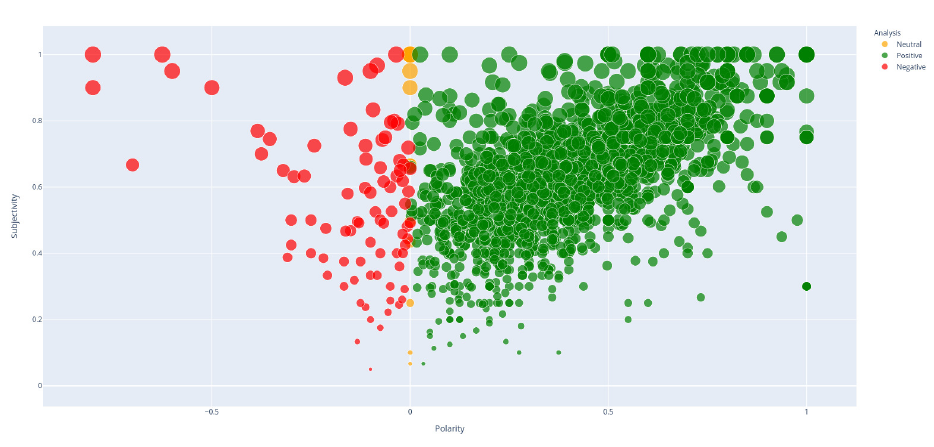
Figure 16. Example of the polarity and subjectivity of the reviews about the Colombian destinations. Obtained from